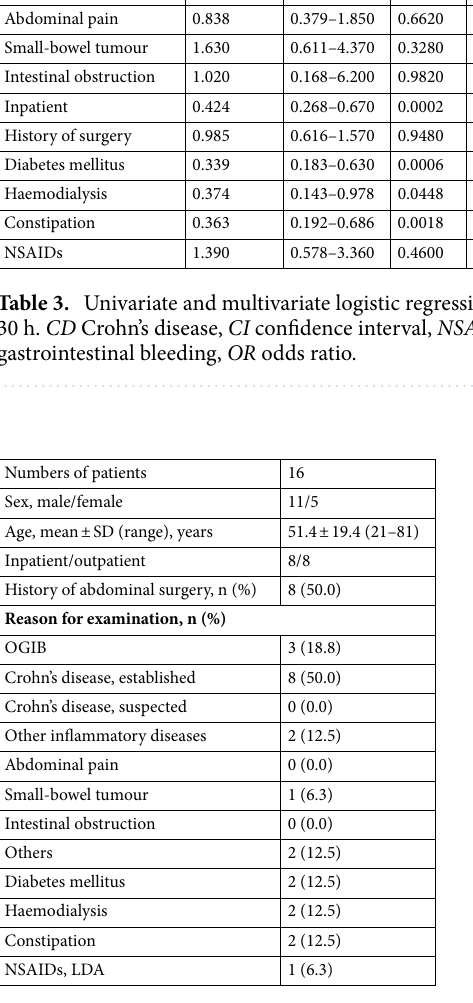
Table 4. Characteristics of the no patency. LDA low-dose aspirin, NSAIDs nonsteroidal anti-inflammatory drugs, OGIB obscure gastrointestinal bleeding, SD standard deviation.